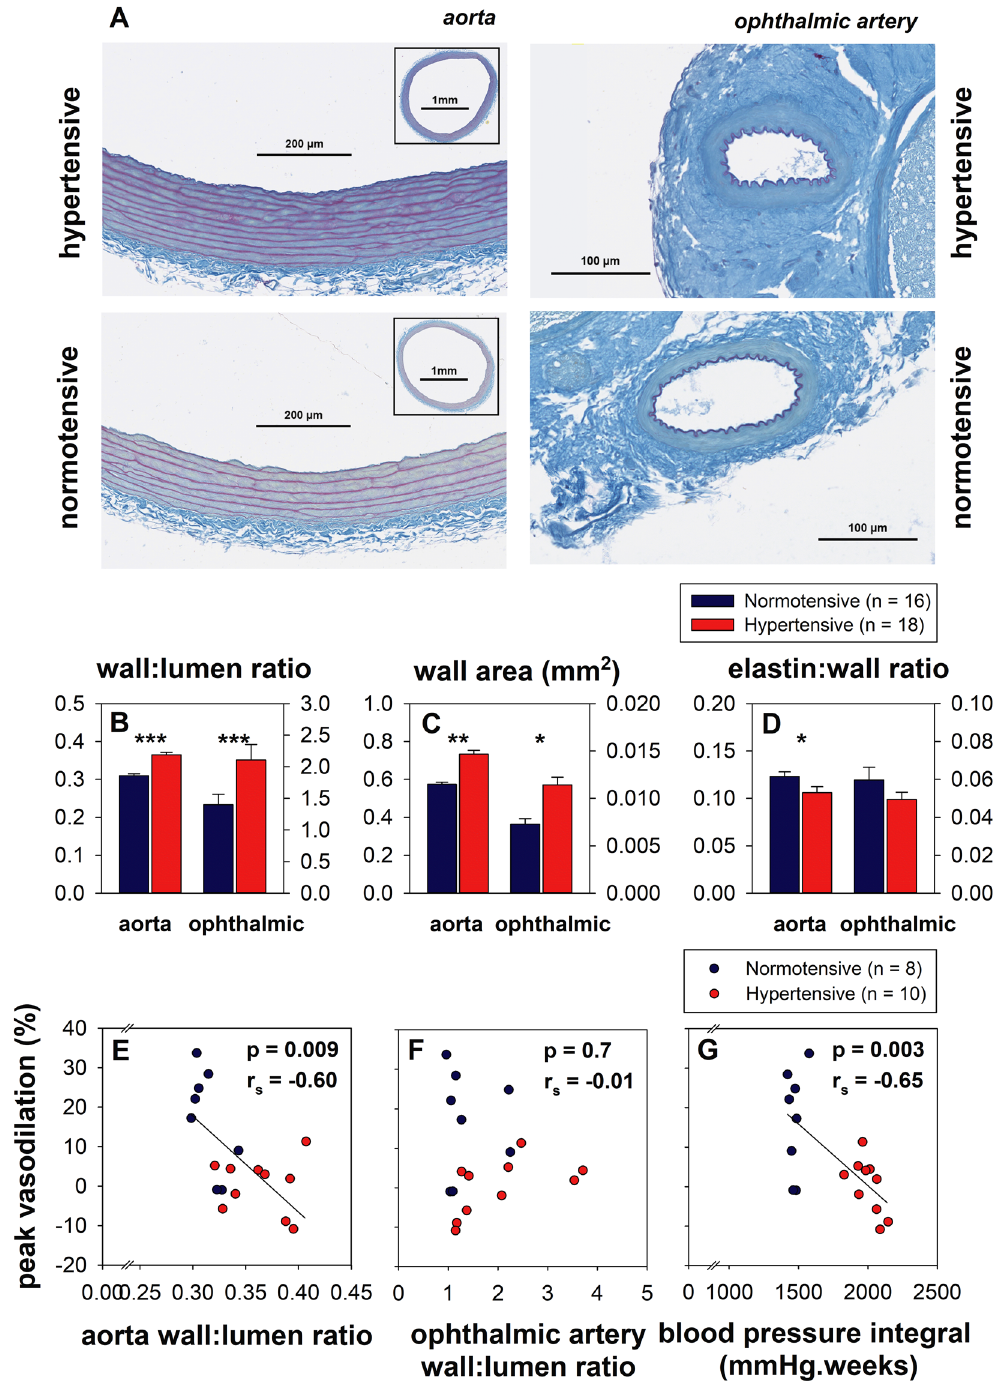
Figure 2. Effect of chronic hypertension on blood vessel morphology. ( A ) Sample hypertensive aorta and ophthalmic arteries from a hypertensive and normotensive rat, with Gomori-Aldehyde Fuchsin staining. ( B ) Aorta and ophthalmic artery wall:lumen ratio. ( C ) Aorta and ophthalmic artery wall area. ( D ) Aorta and ophthalmic artery elastin:wall ratio. ( E ) Correlation between peak vasodilation at low BP and aorta wall:lumen ratio. The solid black line represents the Deming regression (Y = − 243.4X + 90.8, r s = − 0.6, p = 0.009). ( F ) Correlation between peak vasodilation at low BP and ophthalmic artery wall:lumen ratio. (Deming regression Y = − 2.15X + 11.3, r s = − 0.01, p = 0.7) ( G ) Correlation between peak vasodilation at low BP and blood pressure integral over 12 weeks. The solid black line represents the Deming regression (Y = − 0.031X + 62.7, r s = − 0.65, p = 0.003). ( * Indicates p < 0.05, ** Indicates p < 0.01, *** Indicates p <